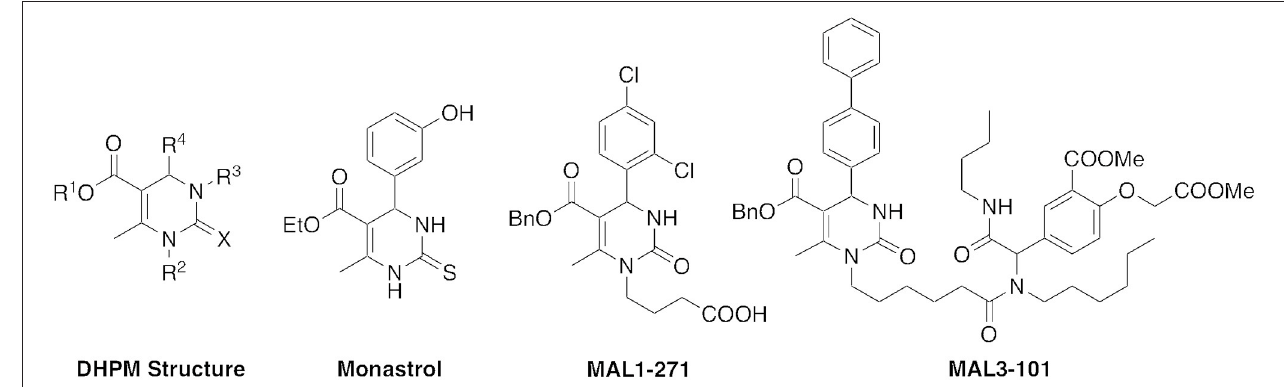
FIGURE 1 | DHPM structure and biologically active